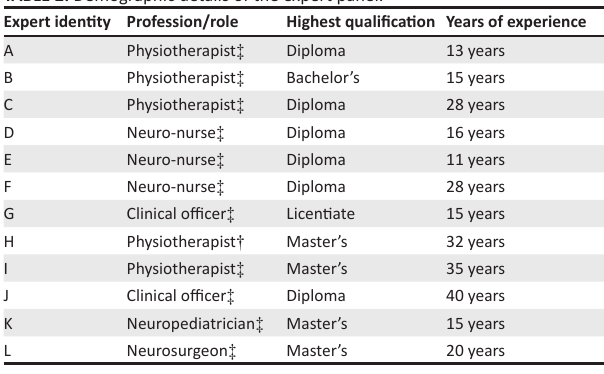
TABLE 2: Demographic details of the expert